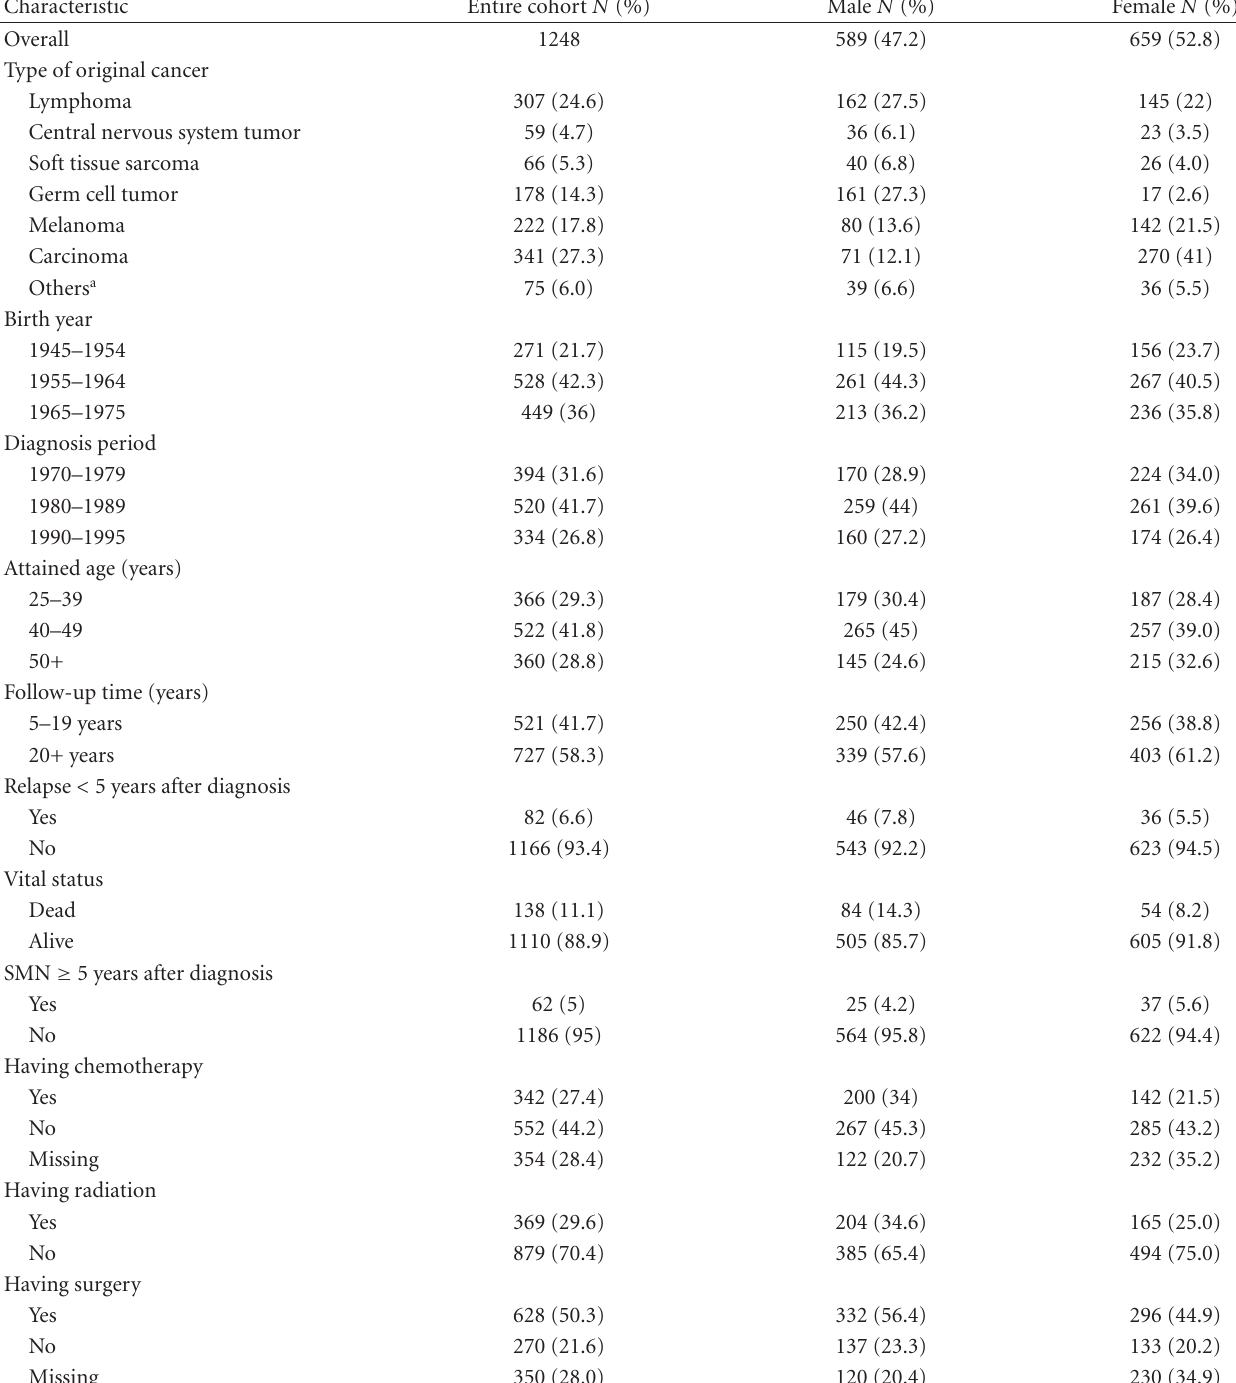
Table 1: Characteristics of young adult cancer survivors by